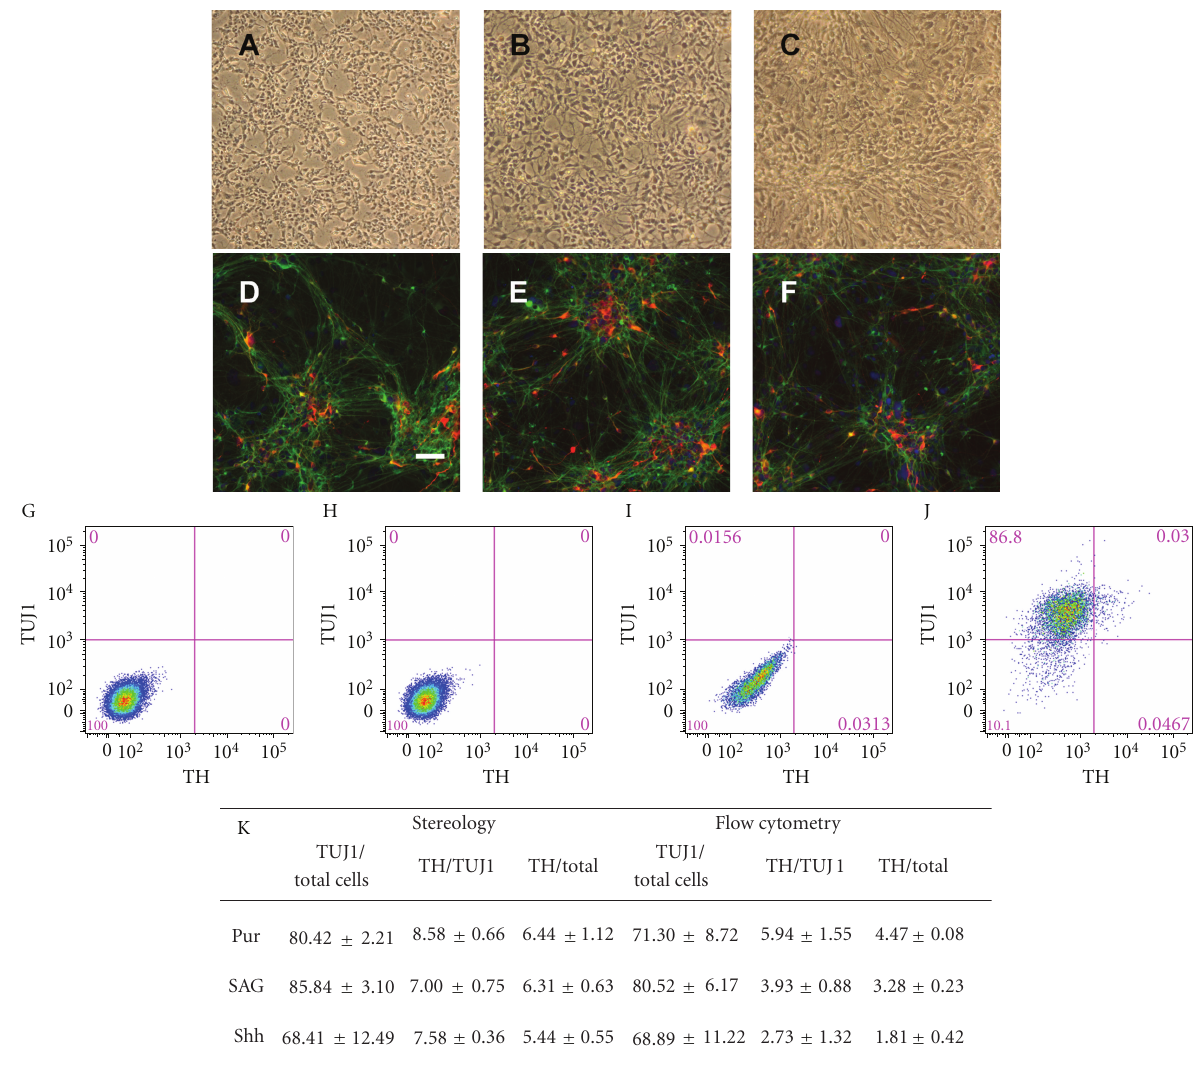
Figure 6: Analysis of number of TH+ and TUJ+ neurons (A)–(C). Image under phase-contrast microscopy showed plating density of NPCs at day 1 in DA1 media (5x magnification) (A), cell morphology at day 12 (arrows indicate the formation of processes) (B) 10x magnification) and neurons at day 30 during dopaminergic maturation (C) 10x magnification). (D)–(F), Neurons treated with Pur (D), SAG (E) and Shh (F) were characterized by immunostaining with TUJ1 (green) and TH (red) and counterstained with DAPI (blue). Scale bar represents 200 μ m. (G)–(J) Flow cytometry: No TUJ1 and TH immunoreactive NPCs were detected (H), which is comparable to unstained NPCs (G). In contrast to the population of unstained di ff erentiated neurons (I), di ff erentiated cells showed positive immunoreactivity to TUJ1 and TH (j). (k) Table illustrates percentage of TUJ1 relative to total cells, TH immunoreactive neurons relative to TUJ1 immunoreactive